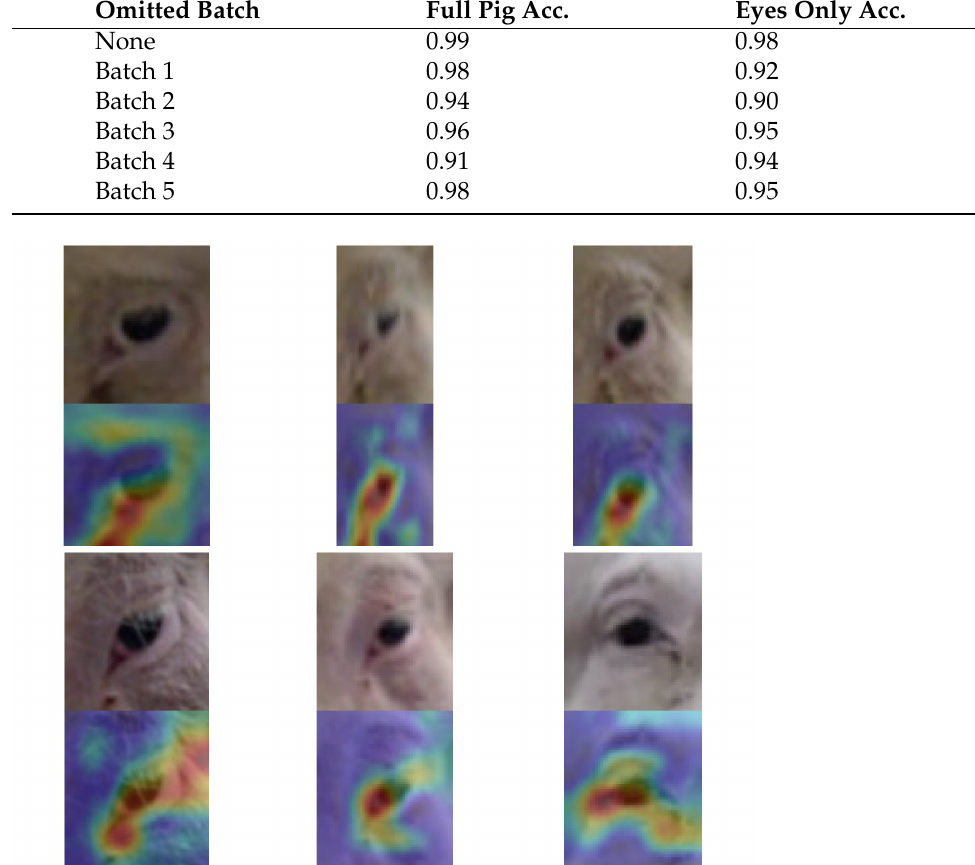
Figure 8. Six Grad-CAM heatmaps from correctly predicted conditions for unstressed (top three), and stressed pigs (bottom three). The input image is also included for easier comparison above each heatmap. The eye and eye-lid regions feature heavily as does the region below the tear-ducts, possibly indicative of using tear staining as a feature (although none of these example images show evidence of